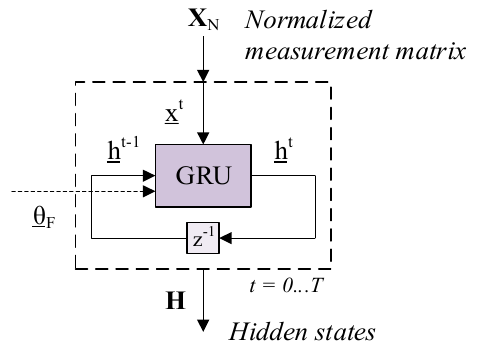
Figure 7. GRU based hidden state matrix computation .